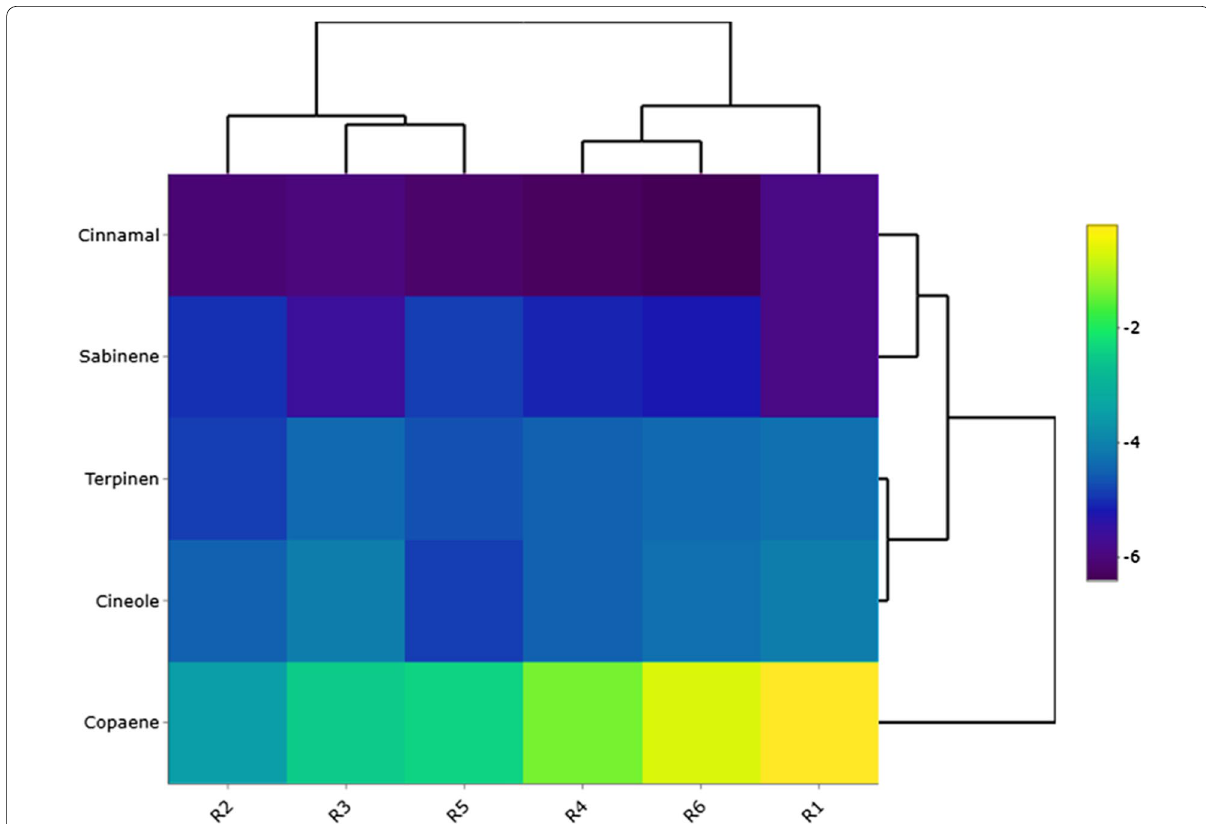
Fig. 6 The correlation of docking energies between ligands and target receptors (R1 R6 =